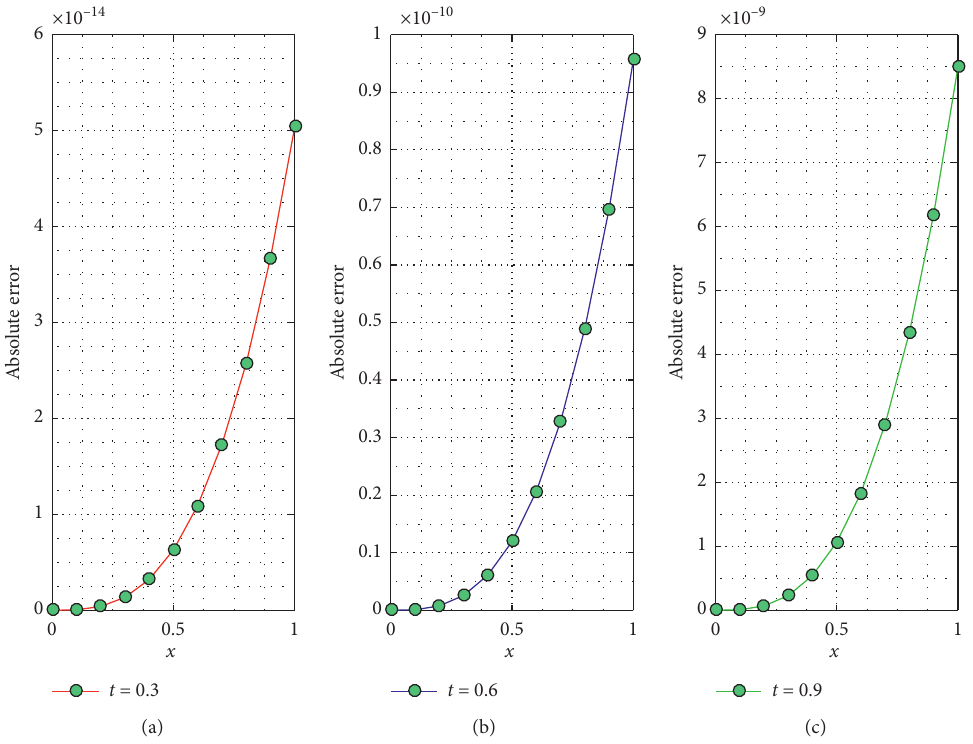
Figure 3: Comparison in terms of absolute errors for Test Problem